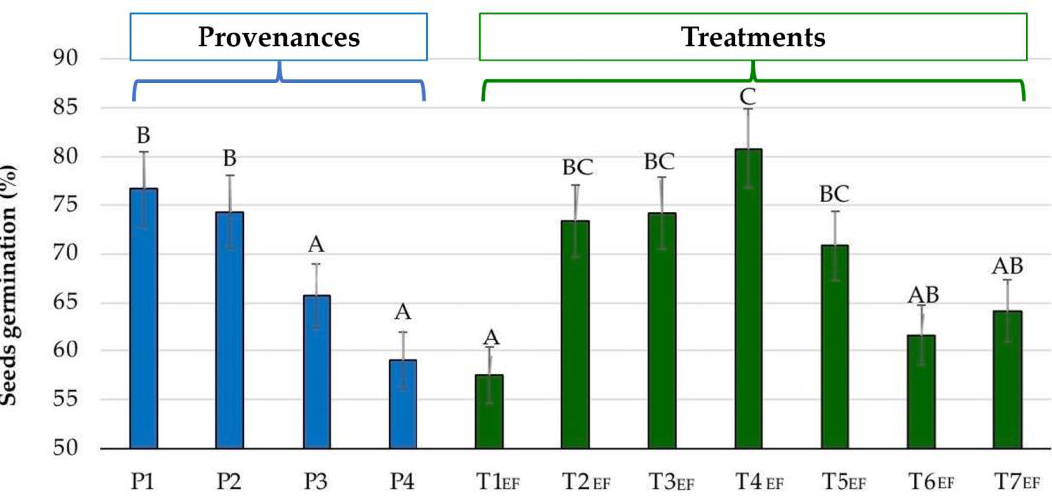
Figure 4. The percentage of seed germination for provenances and EF treatments (mean ± SE; n = 50). The means represented with blue color reflect the influence of the provenance (P1 —Măria Mică, P2 —Făina, P3—Aluniș, and P4 —Putnișoara), regardless of the treatment applied; the means represented with green color reflect the influence of the EF treatment (T1 EF (Control), T2 EF (10 V-15 min), T3 EF (10 V-35 min), T4 EF (30 V-15 min), T5 EF (30 V-35 min), T6 EF (50 V-15 min), and T7 EF (50 V-35 min)), regardless of the provenance. Different (upper case) letters at the top of the bars indicate statistically significant differences between provenances, and respectively treatments, according to Duncan’s MRT test ( p < 0.05).